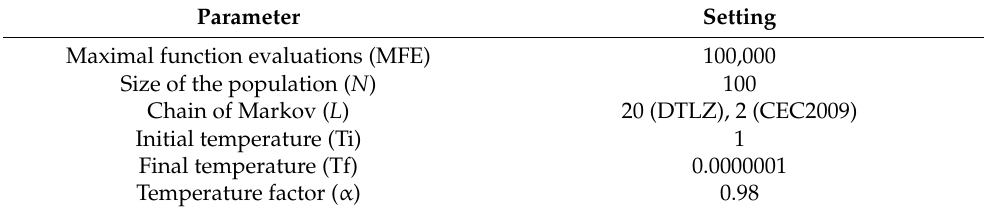
Table 1. General parameter setting.